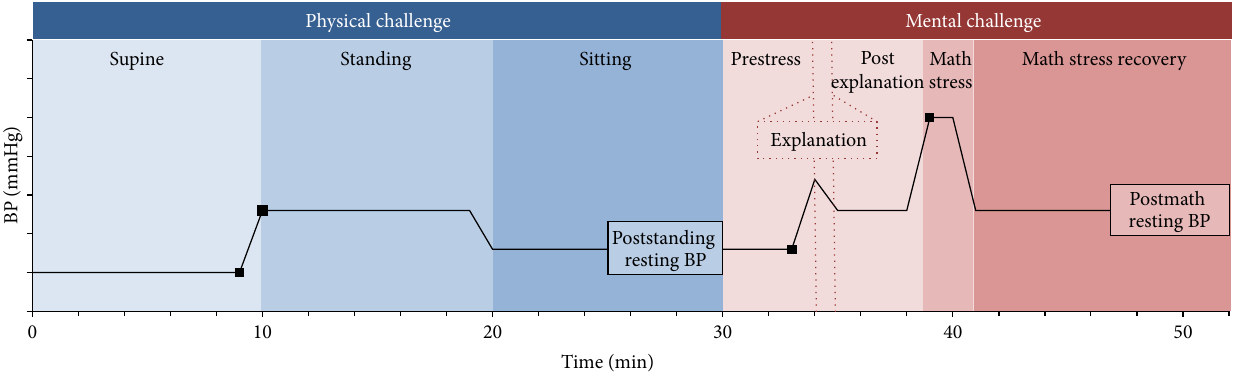
Figure 2: Schematic diagram of the cardiovascular protocol. The cardiovascular protocol consisted of one physical challenge and one mental challenge. The physical challenge was active posture test, which consisted of three periods during which the participant was first supine (10 minutes), then standing (10 minutes), and finally sitting (10 minutes). The mental challenge was a math-stress test, which consisted of a prestress (4min), explanation ( ∼ 1min), postexplanation waiting (4 minutes), math-stress (2 minutes), and math-stress recovery (10 minutes) periods. Black squares indicate the initial and final BP values used to calculate BP reactivity to standing and math stress and the boxes show 5-minute averages of poststanding and postmath resting